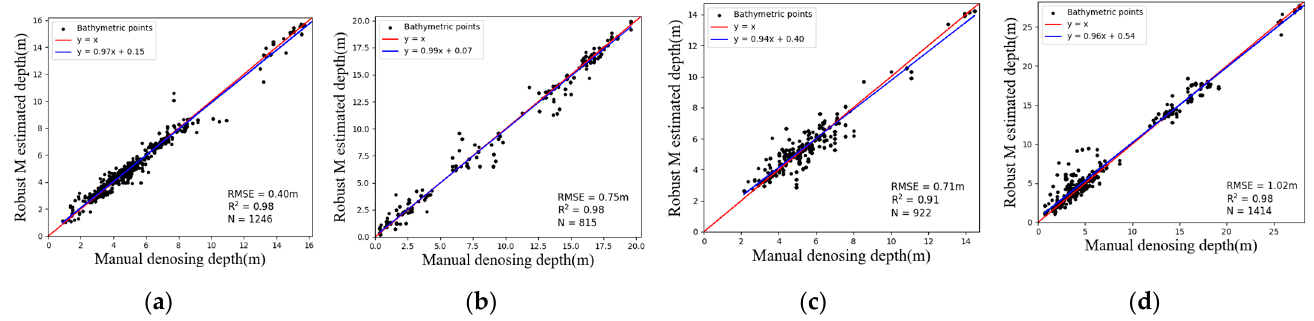
Figure 12. Comparisons of the robust M-estimation depth and manual denoising depth with a ( a ) 480 orbit gt1r beam; ( b ) 480 orbit gt2r beam; ( c ) 1036 orbit gt2r beam; and ( d ) 1036 orbit gt1r beam.